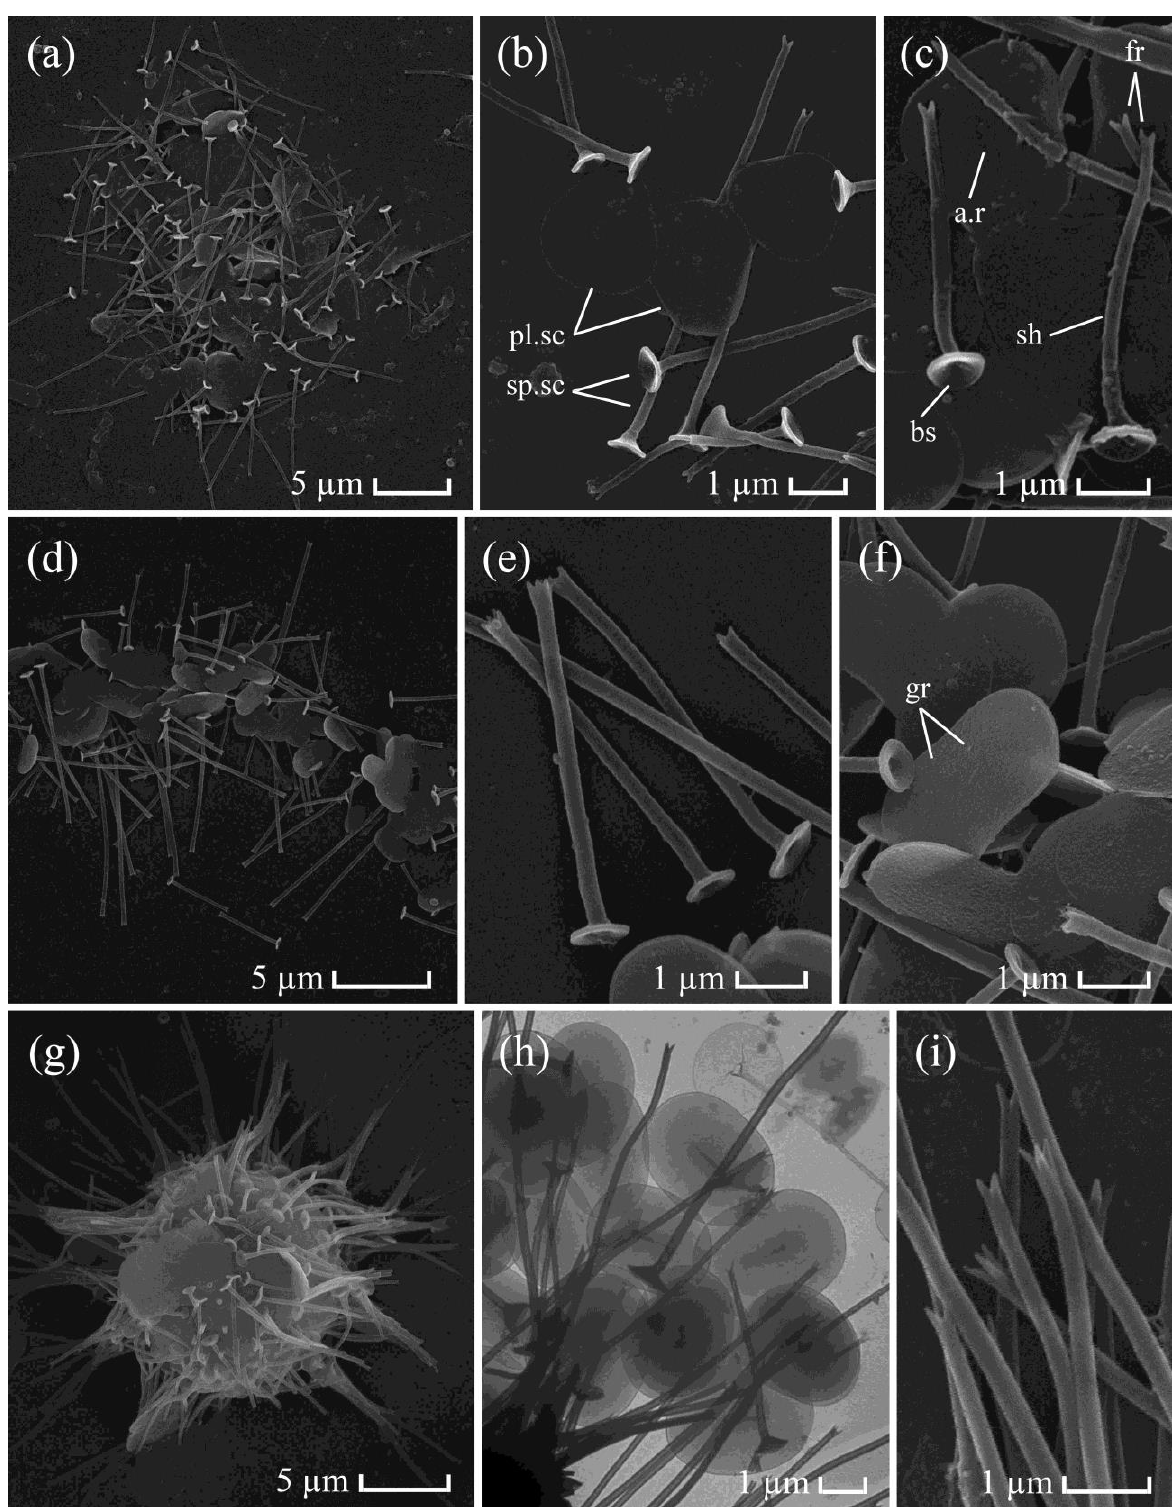
Figure 2. Morphology of observed scales of centrohelid genus Acanthocystis , (a)–(g) and (i) SEM, (h) TEM. (a)–(c) A. nigeriensis : (a) scales of a single cell; (b)–(c) spine and plate scales. (d)–(f) A. penardi : (d) scales of single cell; (e) spine scales; (f) plate scales. (g)–(i) A. trifurca : (g) scales of single cell; (h) spine and plate scales; (i) tips of spine scales. Abbreviations: a.r = axial ridge; bs = base of spine scale; fr = furcae; gr = granules; pl.sc = plate scales; sh = shaft of spine scale; sp.sc = spine